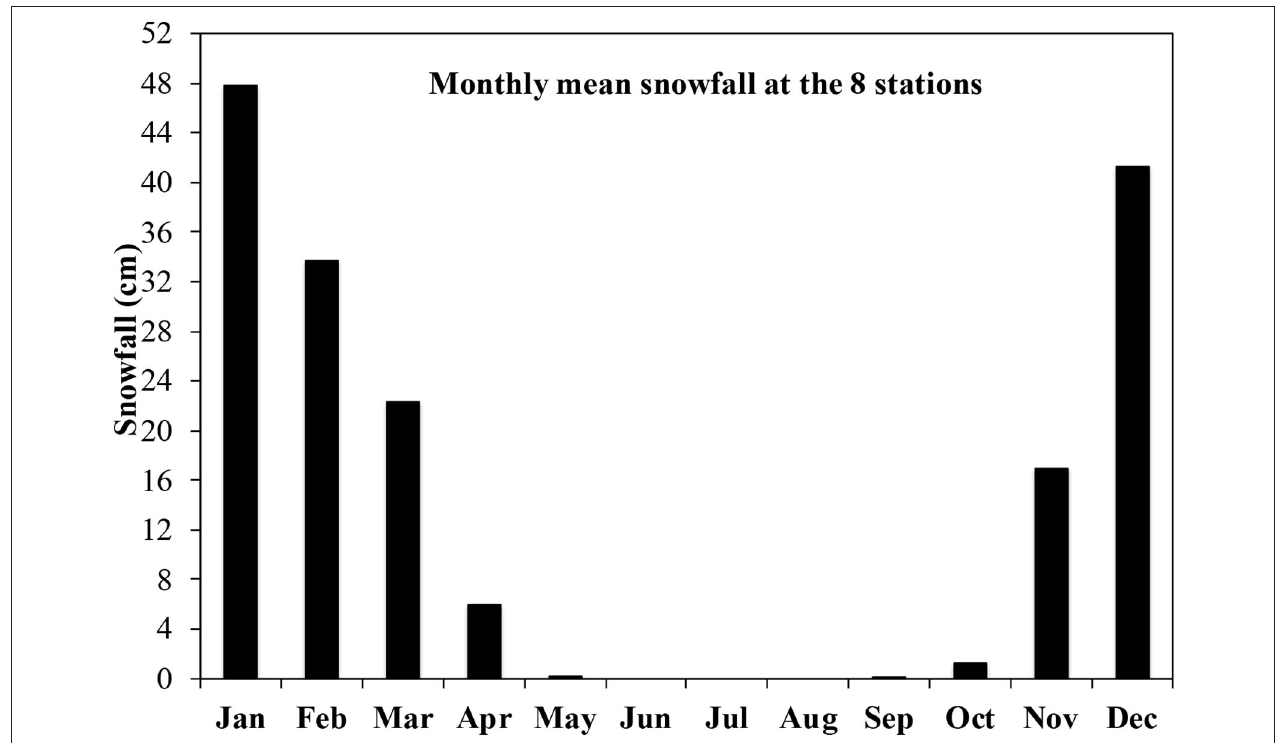
FIGURE 2 | Climatology of monthly snowfall averaged over the eight stations (refer to Figure 1 ) used in this study for the period of 1932–2015.